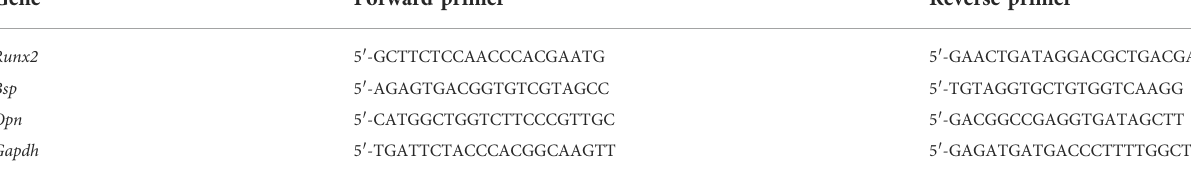
TABLE 1 Sequences of primers used for real-time